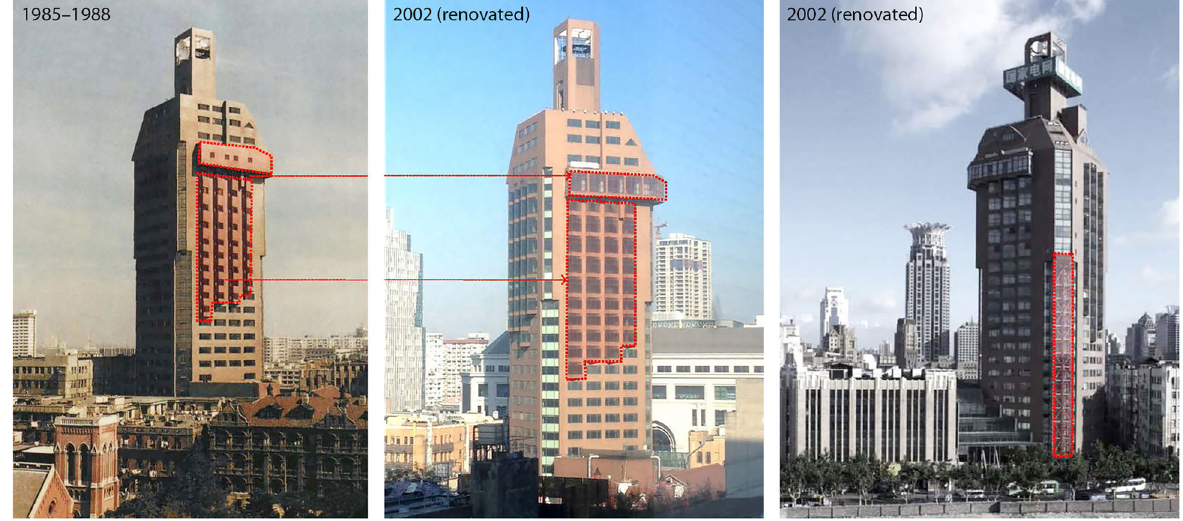
Fig. 8 Modifications of the SECEP Building ’ s form during the 2000s (Source: Based on photographs provided by ECADI)